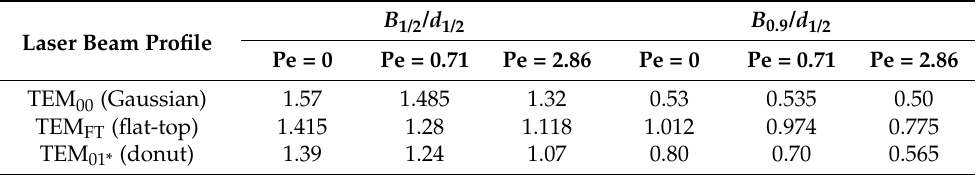
Table 3. Calculated widths of the laser-treated band B 1/2 and B 0.9 versus P é clet’s number. Laser Beam